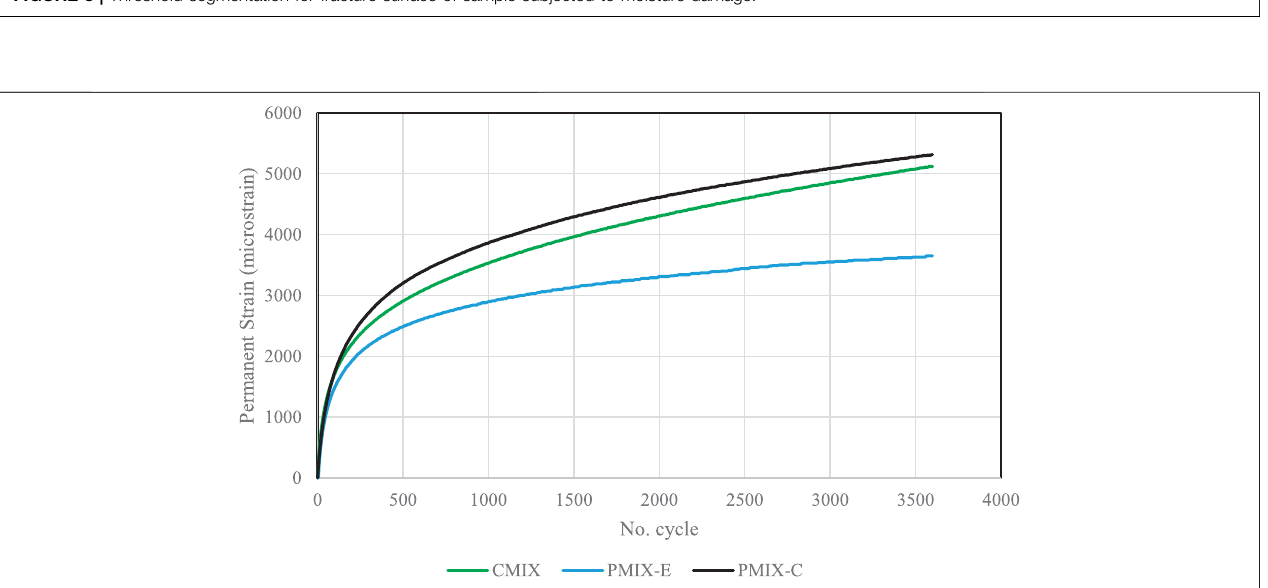
FIGURE 8 | Threshold segmentation for fracture surface of sample subjected to moisture damage.